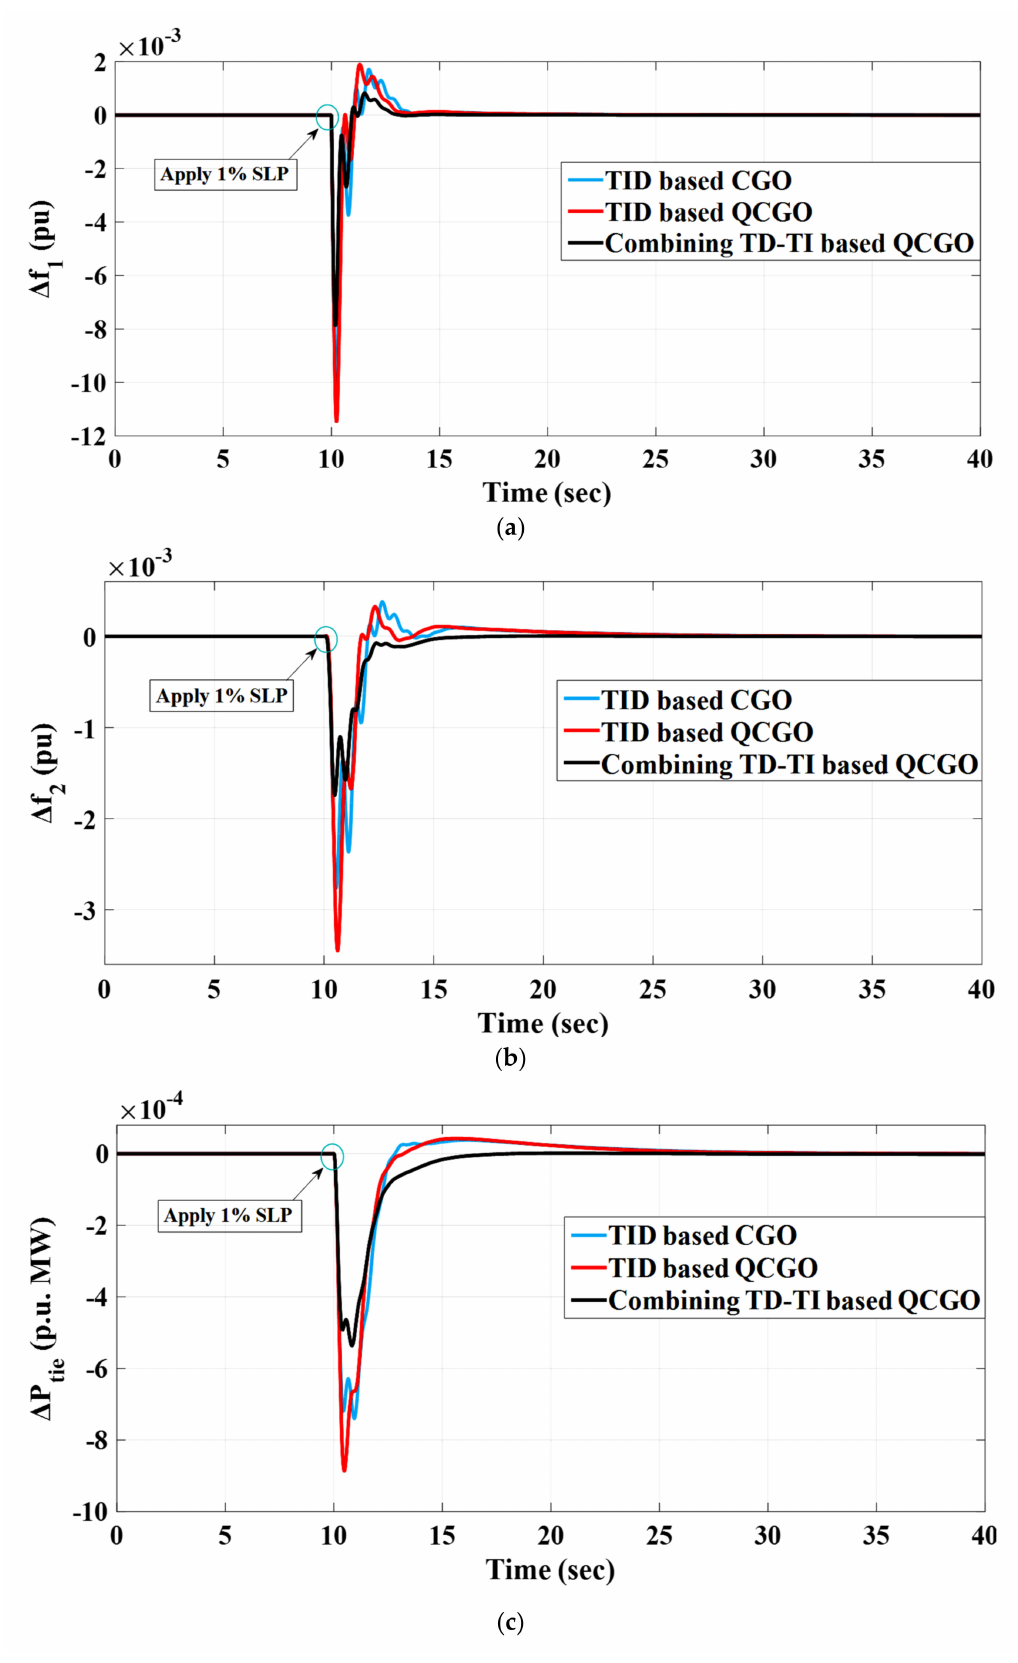
Figure 15. Dynamic power grid responses in case A.1.2: ( a ) ∆ f